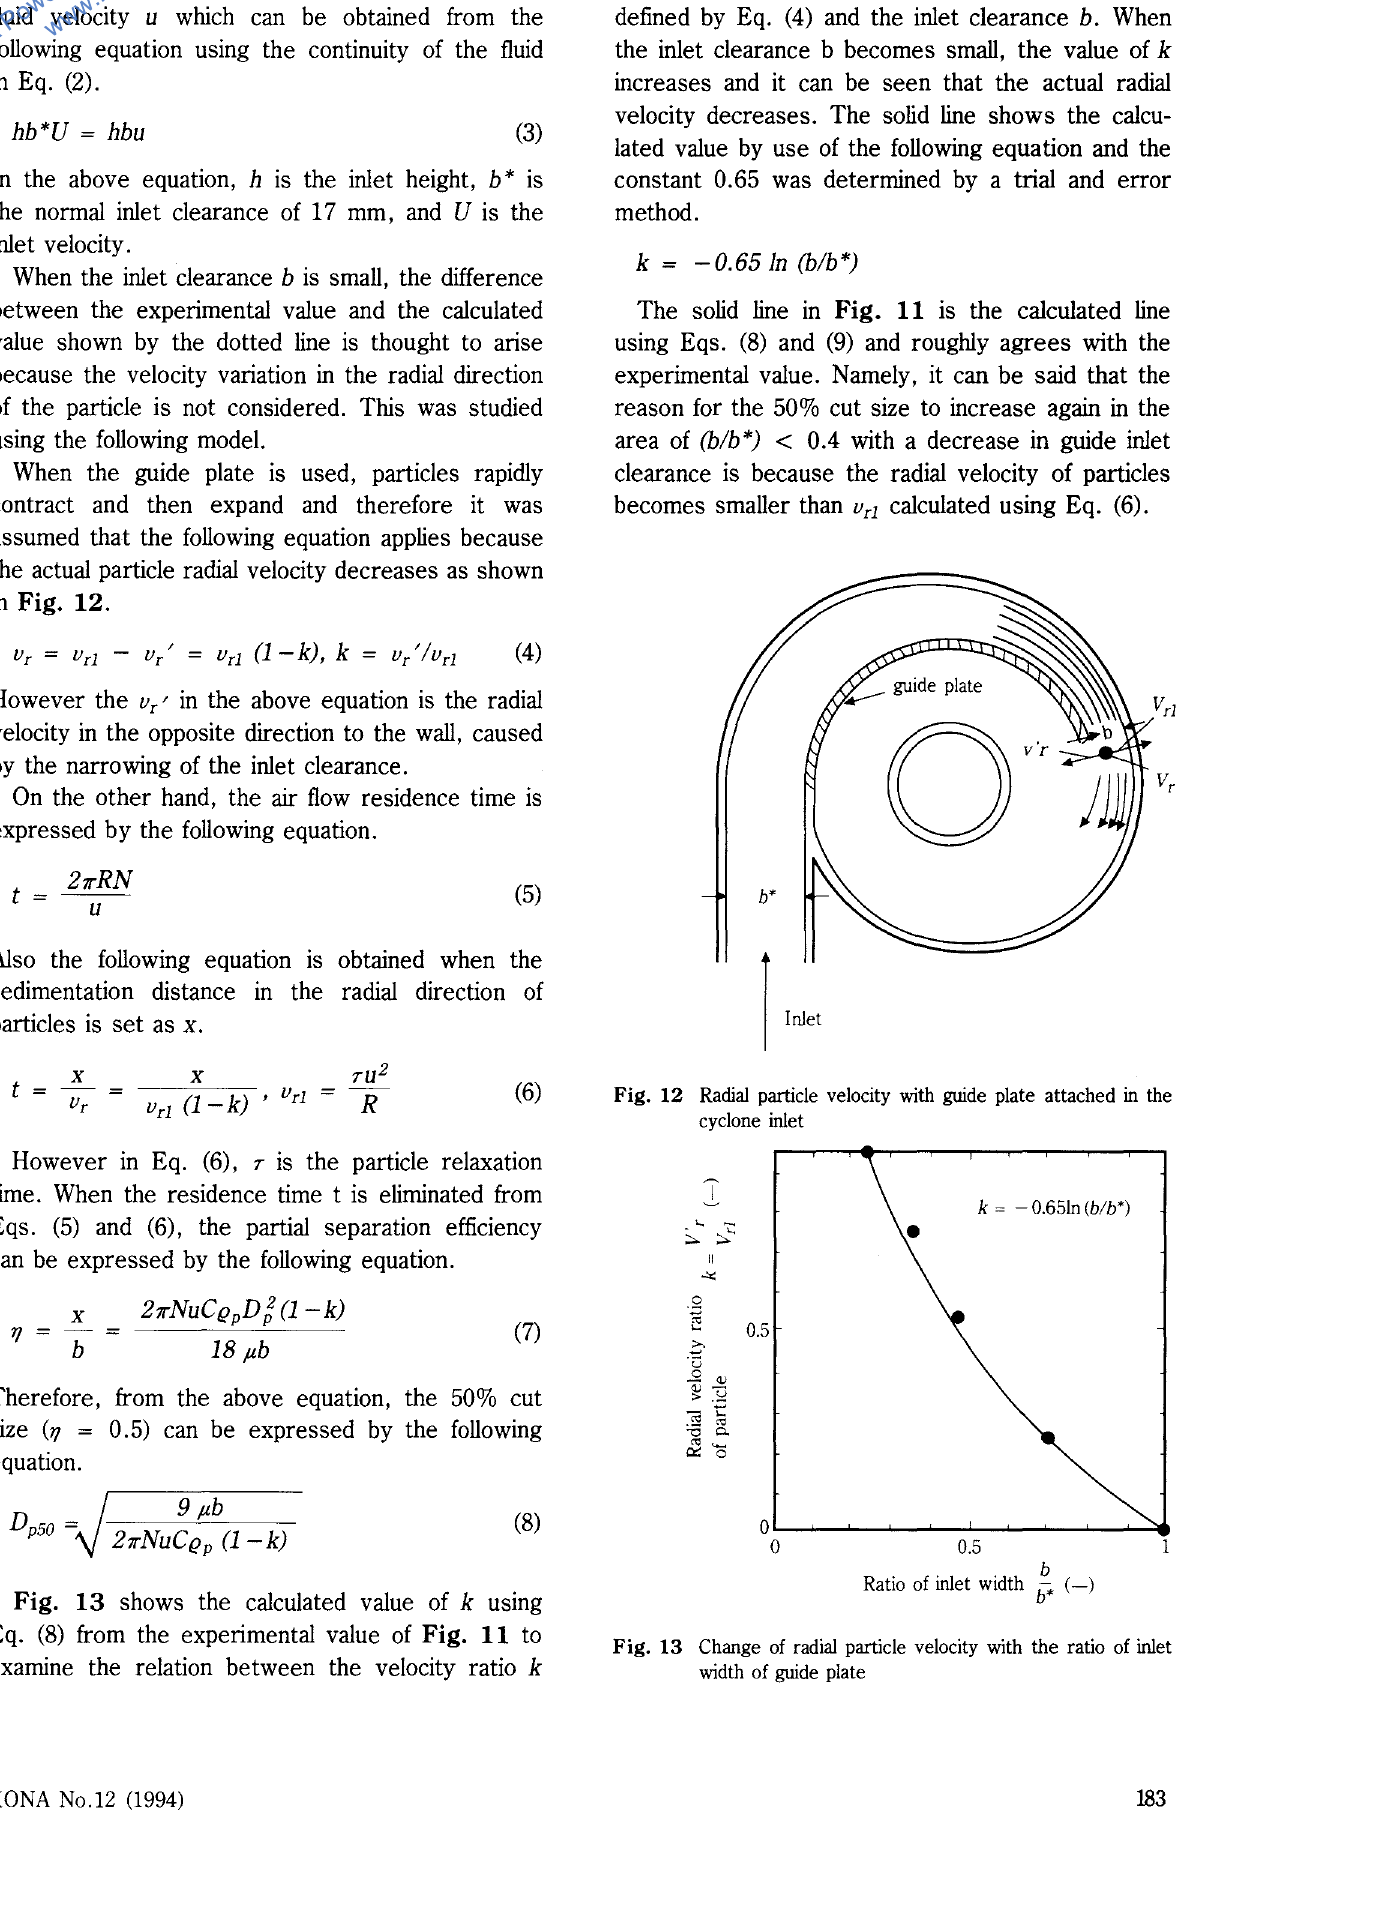
Fig. 12 Radial particle velocity with guide plate attached in the cyclone inlet